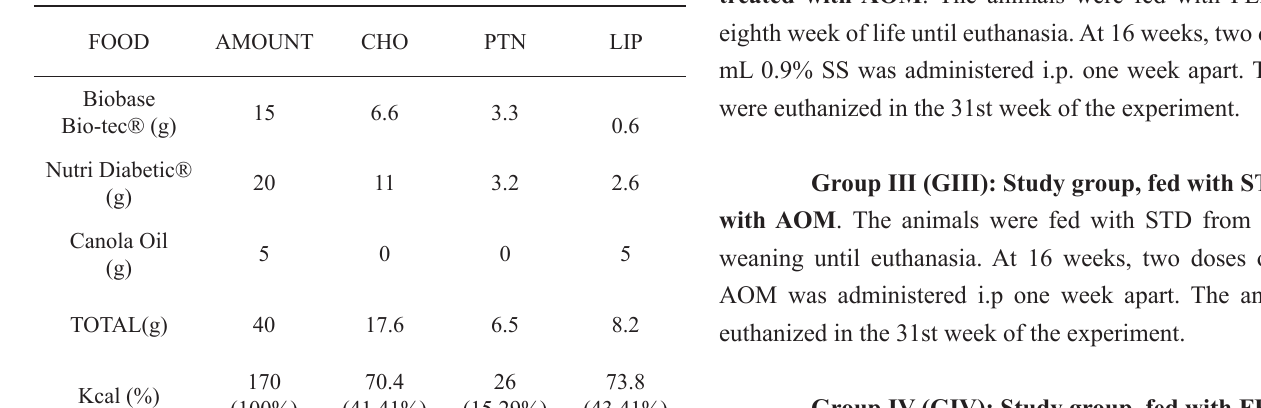
TABLE 2 - Composition of fat-enhanced diet (FED): hypoglycidic, normoproteic, hyperlipidic.